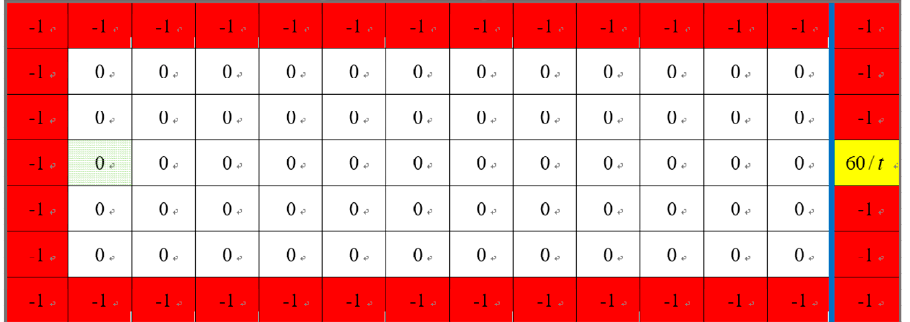
( h ) Figure 20. Snapshot of the one learning process: ( a ) robot is suspended by the automatic training platform in the start state; ( b ) robot is lowered by the automatic training platform in the start state; ( c ) automatic training platform moves forward to follow the robot in the operation state; ( d ) automatic training platform moves forward and right to follow the robot in the operation state; ( e ) robot is in the danger region and is followed by the automatic training platform in the end state; ( f ) robot is pulled up by the automatic training platform in the end state; ( g ) automatic training platform goes back in the return state; ( h ) automatic training platform is at the initial position in the return state. Based on the proposed learning framework, there were a total of 594 episodes executed to learn the straightforward gait pattern for the humanoid robot. The target region, with a center of 229.5 cm, 59.5 cm, was located in front of the initial position (25.5 cm, 59.5 cm) where the humanoid robot began walking in each episode. The target distance was where the x -coordinate of the training field was 221 cm. In the learning process, an episode was terminated when the humanoid robot reached the danger region or the target region. The Q-table could be updated by selecting the turning